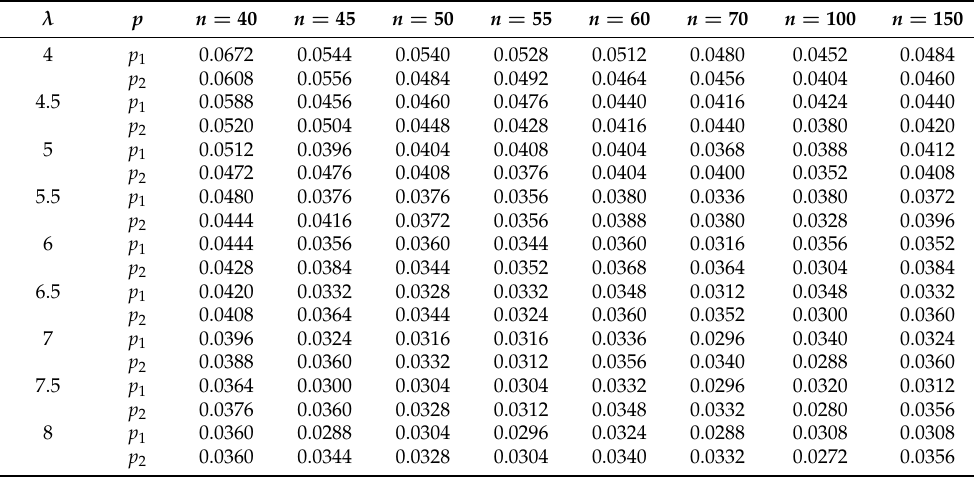
Table A1. Simulated Type I error probabilities of hypothesis testing problem